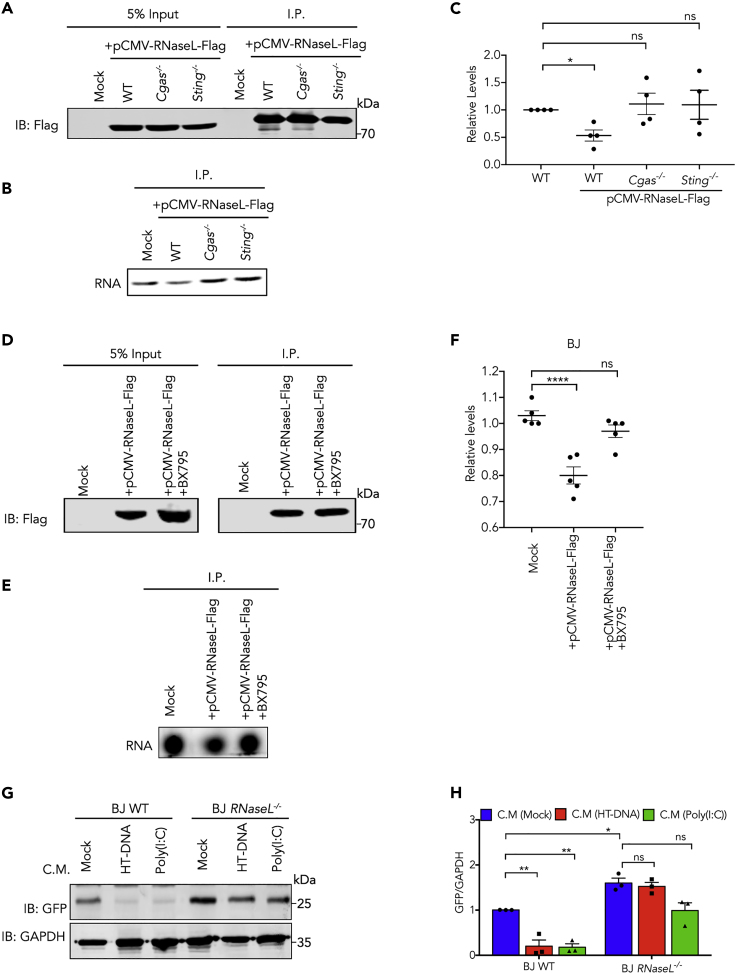
DNA Transfection Induces RNaseL Activity through cGAS-STING and Interferon Pathways(A) L929 cells of indicated genotypes were transfected with a plasmid expressing Flag tagged RNaseL. Lysates containing comparable total amount of RNAseL-Flag protein were subjected to immunoprecipitation (IP) with Flag(M2) beads. Western blot showing levels of RNaseL-Flag in 5% input and IP.(B) RNaseL activities in IP products in (A) were measured by incubation with a fluorescent RNA oligonucleotide and gel electrophoresis.(C) Quantification of band intensity in (B).(D) BJ-5ta cells were treated with BX795 or DMSO and transfected with a plasmid expressing Flag tagged RNaseL, which was immunoprecipitated (IP) with Flag(M2) beads. Western blot showing levels of RNaseL-Flag in input and IP.(E) RNaseL activities in IP products in (D) were measured by incubation with a fluorescent RNA oligonucleotide and gel electrophoresis.(F) Quantification of band intensity in (E).In (C) and (F), data represent mean ± SEM of >3 independent experiments. ∗p < 0.05, ∗∗∗∗p < 0.0001 (one-way ANOVA versus WT or Mock, with Dunnett's correction). Ns, not significant.(G) Wild-type and RNaseL−/− BJ-5ta cells were treated with conditioned media from cells exposed to HT-DNA or Poly(I:C), then transfected with pEGFP-N1 plasmid for 24 h; levels of GFP protein was analyzed by western blot.(H) Quantification of GFP bands in (G). Data represent mean ± SEM of three independent experiments. ∗p < 0.05, ∗∗p < 0.01 (two-way ANOVA, Tukey's correction). Ns, not significant.